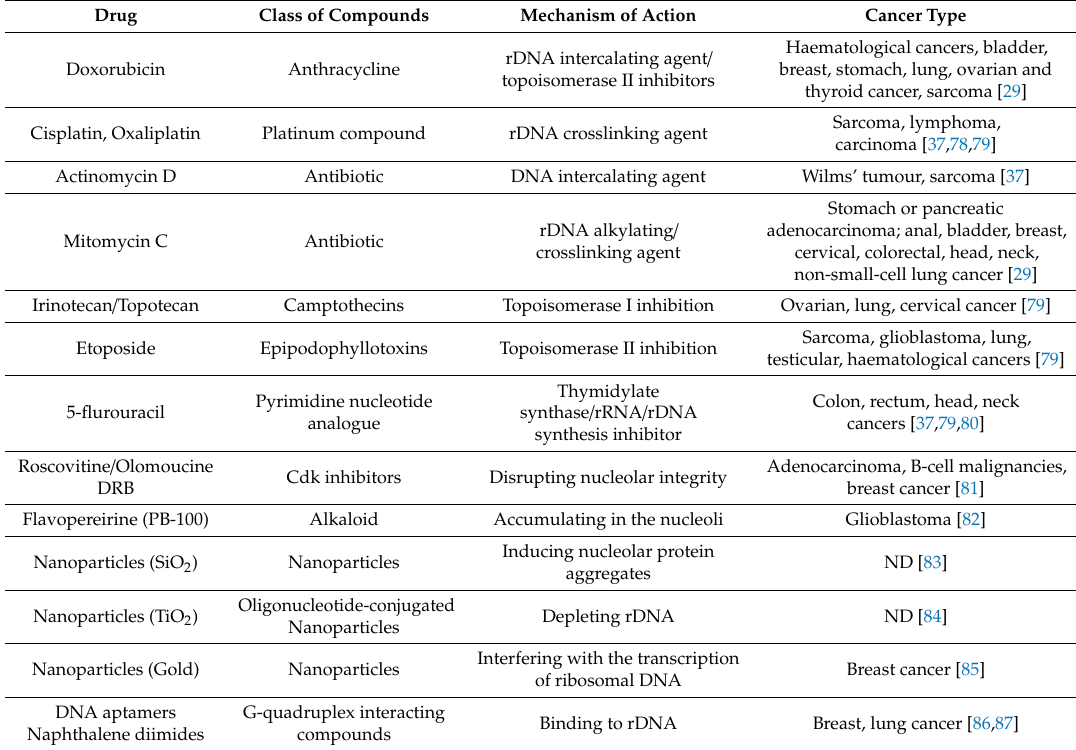
Table 1. Classification of Compounds targeting Nucleolar Components.